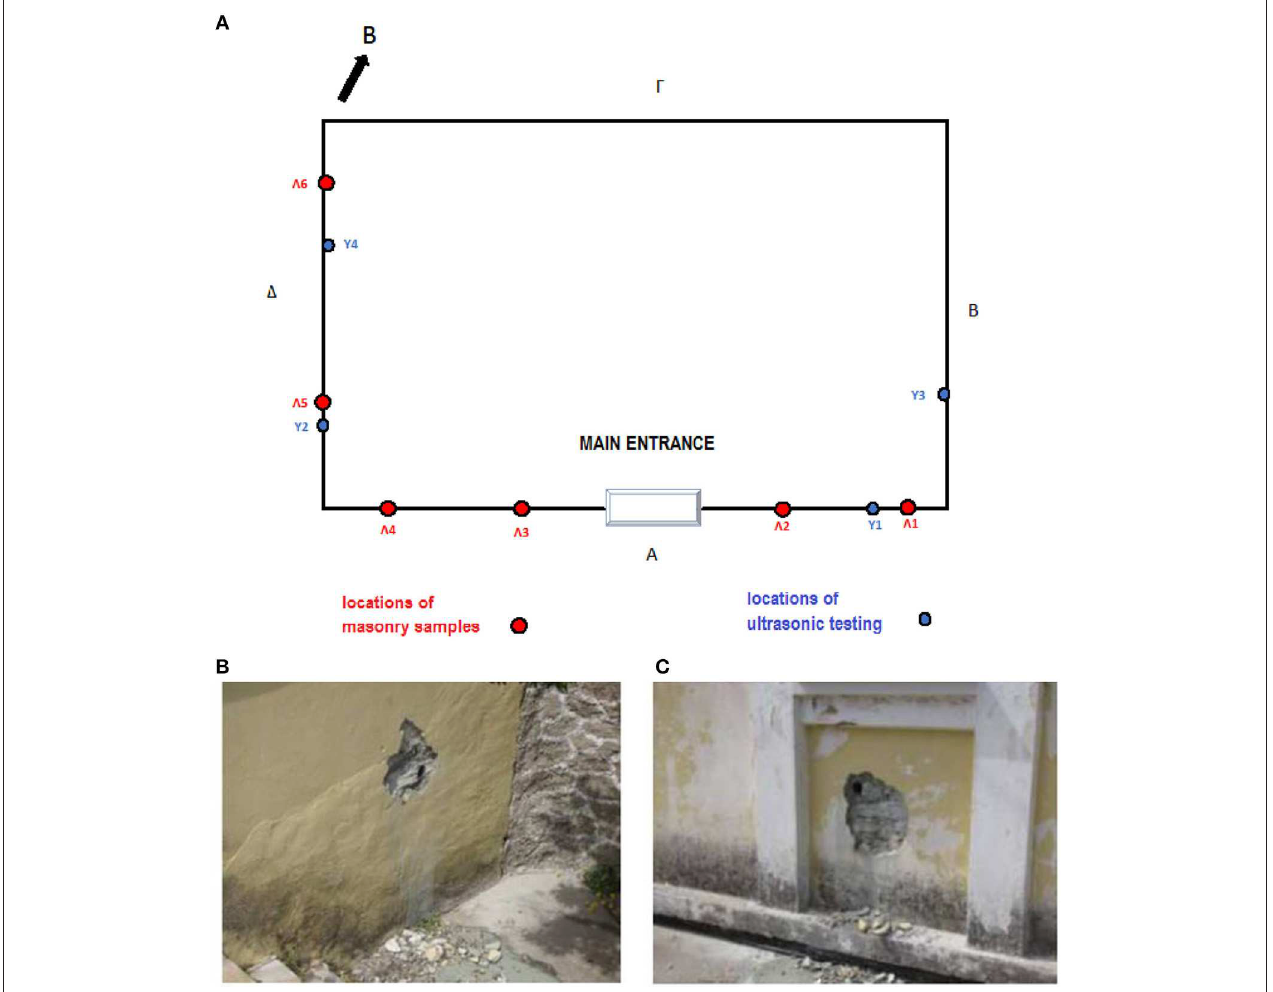
FIGURE 3 | (A) Plan view with the locations where masonry samples were extracted (red colored) and ultrasonic testing was performed (blue coloreed), (B) masonry sample 3 1, (C) masonry sample 3